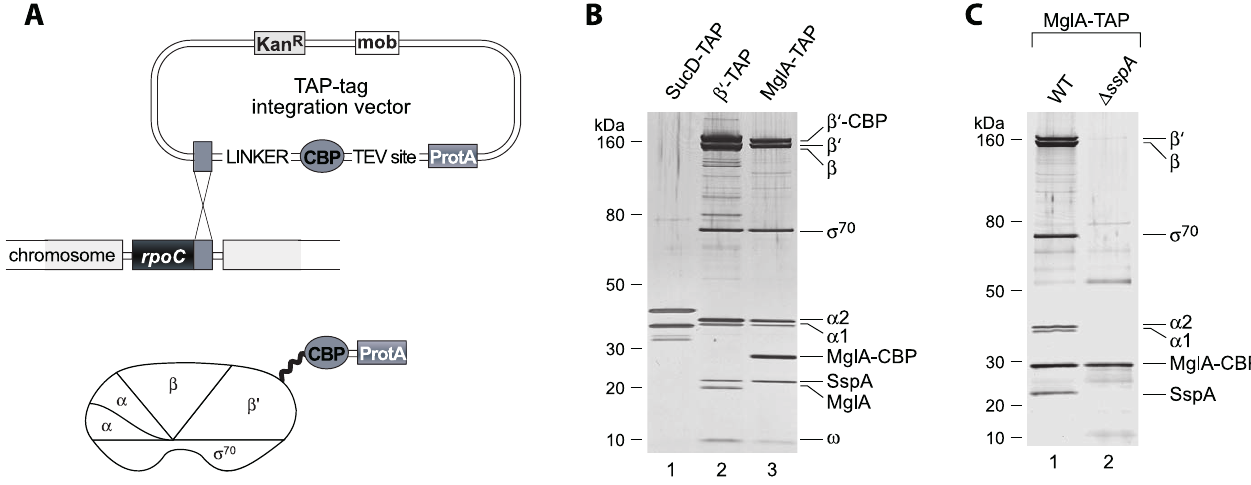
Figure 1. MglA and SspA Are Associated with RNAP in F. tularensis (A) Schematic representation of the TAP-tag integration vector and its use in making b 9 -TAP. The calmodulin binding peptide (CBP), protein A moieties (ProtA), and TEV cleavage site that constitute the TAP-tag are shown [17], together with the kanamycin resistance determinant (Kan R ) and the mobilization region (mob). (B) SDS-PAGE analysis of proteins that co-purify with SucD-TAP, b 9 -TAP, and MglA-TAP from F. tularensis . Protein complexes were tandem affinity purified, electrophoresed on a 4%–12% Bis-Tris NuPAGE gel, and stained with silver. Lane 1, proteins purified from strain LVS SucD-TAP. Lane 2, proteins purified from strain LVS b 9 -TAP. Lane 3, proteins purified from strain LVS MglA-TAP. MglA, SspA, and subunits of RNAP are indicated together with the b 9 -CBP and MglA-CBP fusions that result following cleavage of each corresponding TAP fusion with TEV protease. MS/MS analyses revealed that many of the proteins that run between the b and r 70 subunits of RNAP (in lane 2) are breakdown products of the b subunit (unpublished data). (C) SDS-PAGE analysis of proteins that co-purify with MglA-TAP in a wild-type (WT, lane 1) or in a D sspA mutant background (lane 2). Protein complexes were tandem affinity purified, electrophoresed on a 4%–12% Bis-Tris NuPAGE gel, and stained with silver. Lane 1, proteins purified from strain LVS MglA- TAP. Lane 2, proteins purified from strain LVS D sspA MglA-TAP. Molecular weights are indicated on the